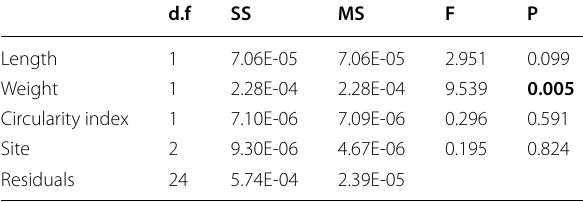
Table 2 ANCOVA results on the sedimentation velocity of A. dealbata’ s seeds . Significant results are highlighted in